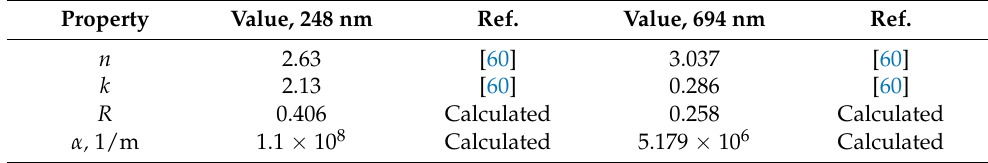
Table A14. c -CdTe—optical properties.